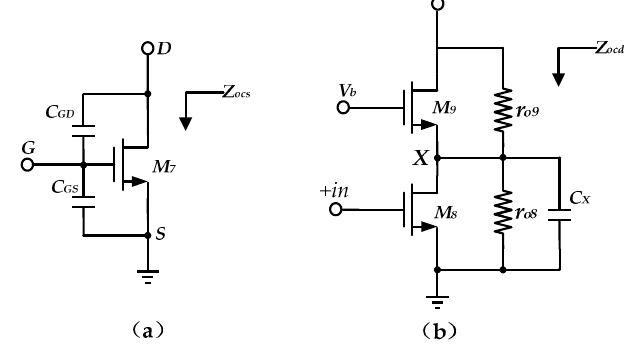
Figure 8. The common source (CS) amplifier ( a ) and the cascode amplifier ( b ).